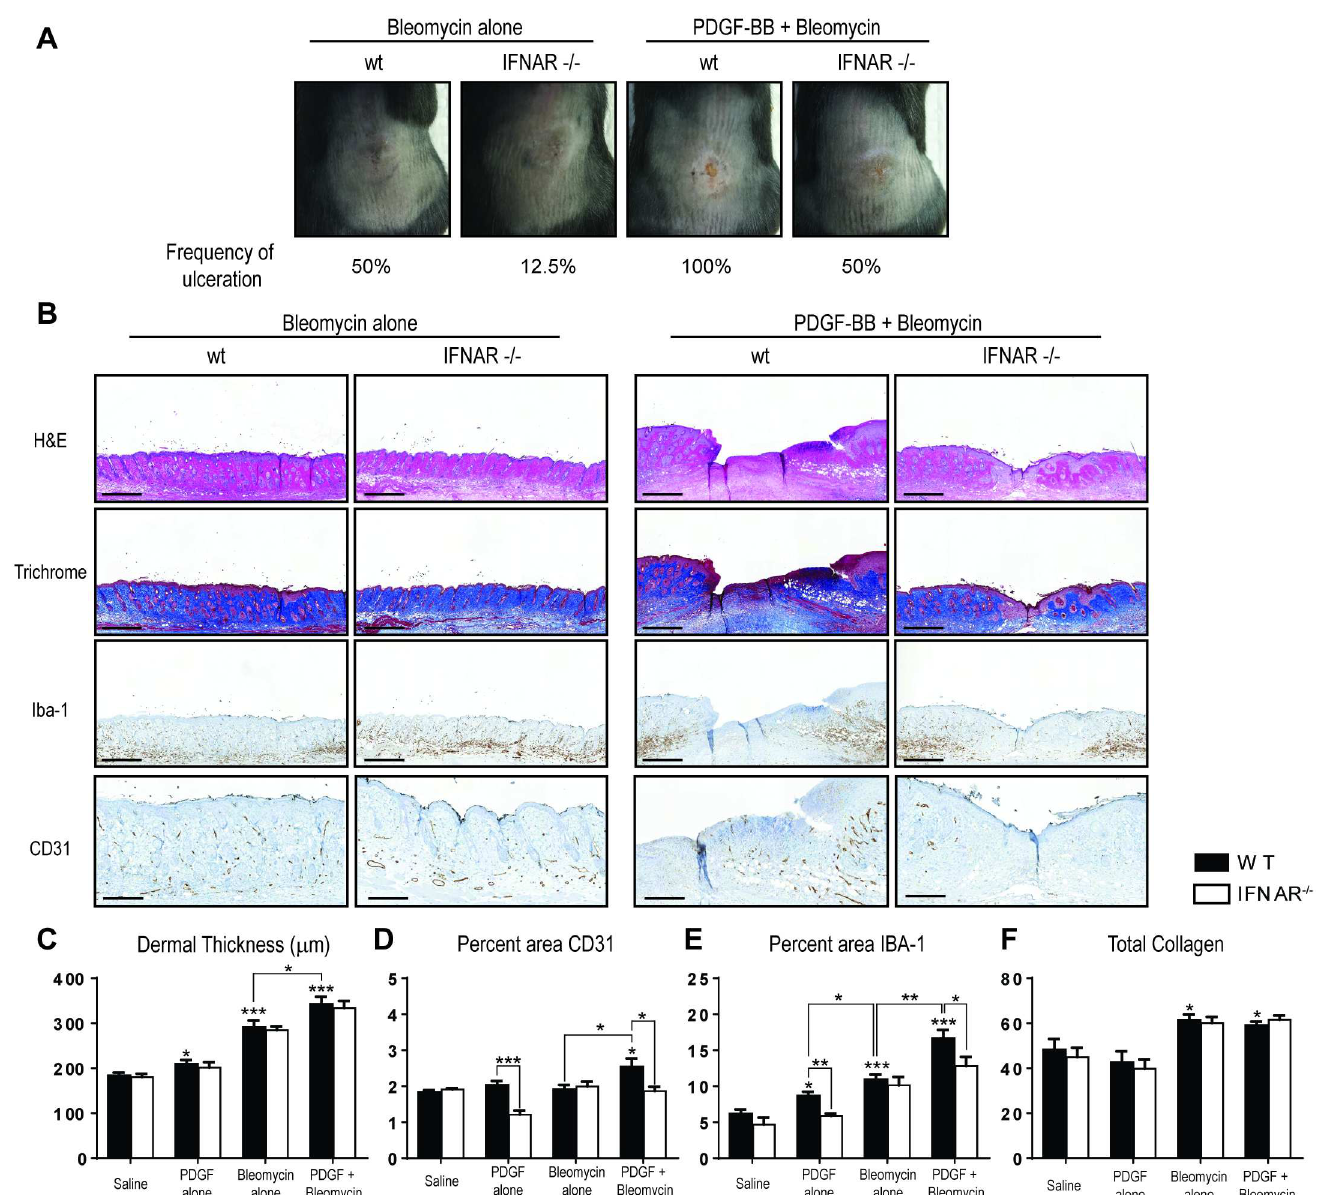
Fig 4. IFNAR activationis necessaryfor bloodvesselstabilizationand recruitmentof monocyte/macrophage cells in PDGF-BB + bleomycin- treatedmice. (A) Representative photographs of skin lesions on backs of treatedwildtypeor IFNAR-deficient mice. Frequency of ulcerationwas calculatedbased on visual examination of H&E stainedtissue sections. (B) Representative skin sectionof treatedmice stainedby H&E, trichrome,anti- IBA-1,or anti-CD31 immunohistochemistry(scale bar for H&E, trichrome,and anti-IBA-1: 500 μ m, scale bar for anti-CD31: 300 μ m).(C-F) Quantification of dermalthickness (C),percentarea CD31 (E) or percentarea IBA-1 (F) immunoreactivity, or totalcollagen (D) stainingas determined by imageanalysis as described in the methods. * P < 0.05, ** P < 0.01, *** P < 0.001,versus saline or for bracketed comparisons shown (student’s t